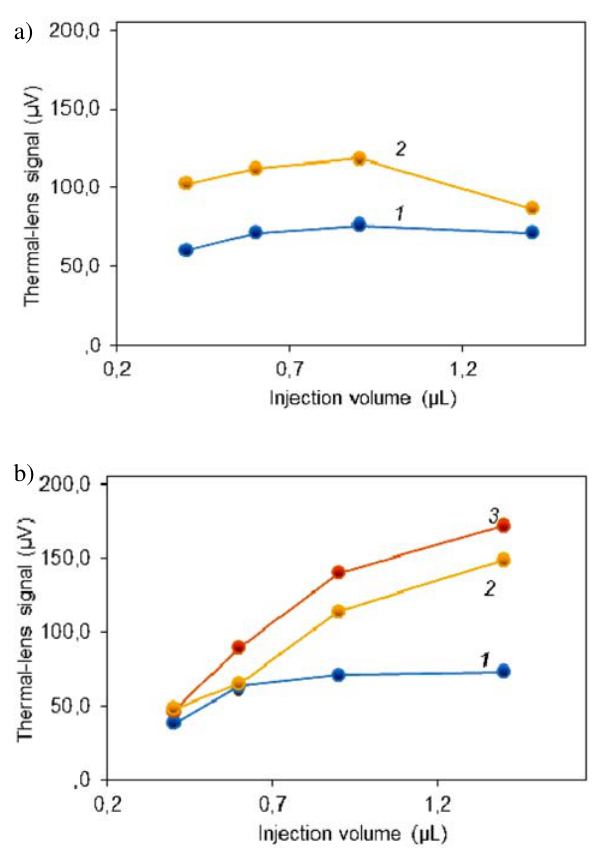
Figure 6. Dependence of the thermal-lens signal of Cr(VI) (4 μmol L –1 ) complex with diphenylcarbazide (20 μmol L –1 ) on the injection volume of the reagent for various detection positions from the mi- xing point: flow rate, (a) 5 μL min –1 , 1 , D cm and (b) 10 μL min –1 , 1 , D cm; excitation power, 100 mW.